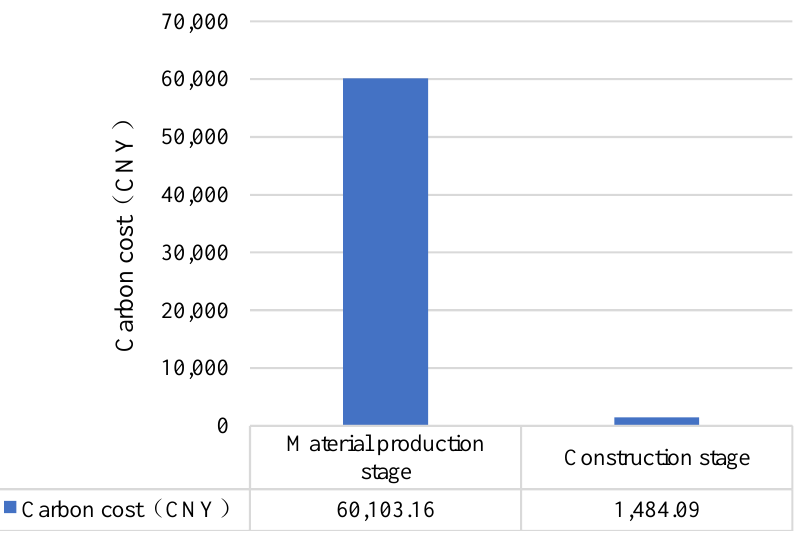
Figure 8. Carbon cost under the carbon trading system.